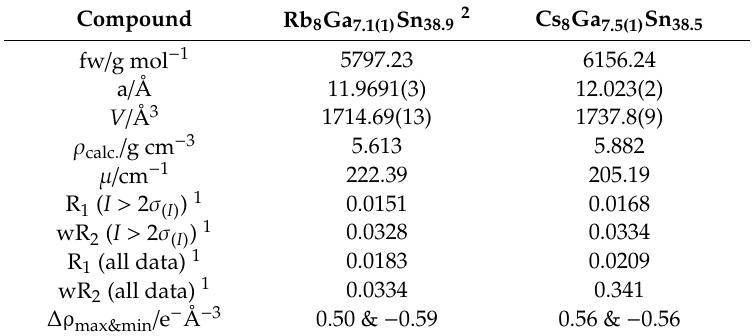
Selected crystal data and structure refinement parameters for Rb 8 Ga 7.1(1) Sn 38.9